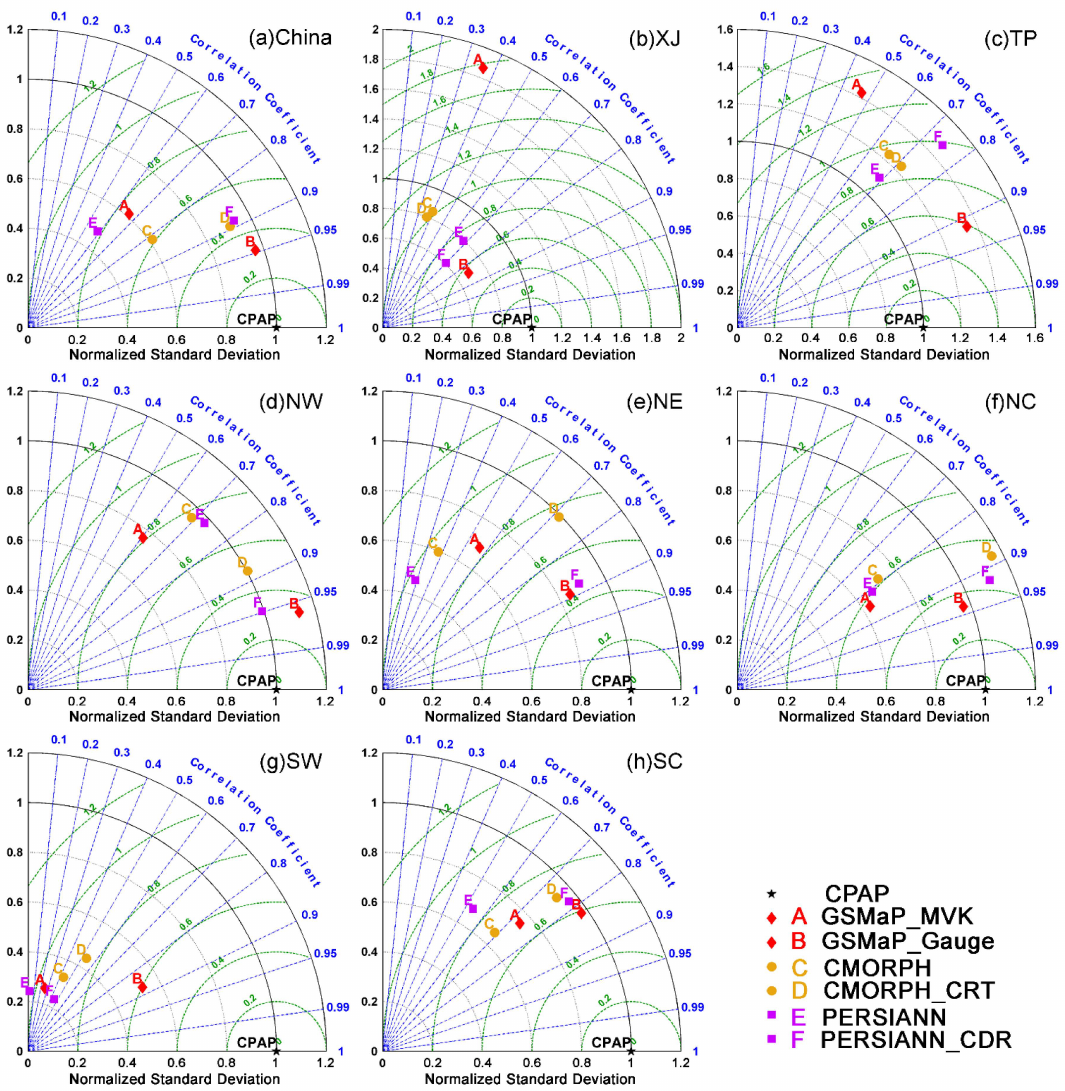
Figure 4. Taylor diagrams showing the correlation coefficients, the normalized standard deviation, and the RMSE of four year daily mean precipitation between six satellite-based precipitation products and the reference data over ( a ) mainland China and seven sub-regions: ( b ) XJ; ( c ) TP; ( d ) NW; ( e ) NE; ( f ) NC; ( g ) SW; and ( h ) SC. The radial coordinate is the magnitude of the standard deviation, which is normalized by the standard deviation from CPAP and denoted by black dotted lines. The concentric green semi-circles denote RMSE values. The angular coordinate shows the correlation coefficient (denoted by blue dotted lines). In these Taylor diagrams, the closer the points representing the satellite-based precipitation products are to the CPAP point (marked by the black pentagon), the better the product is with relatively high correlation, low standard deviation and RMSE values. The products from the same algorithm are marked by the same marker with same color and denoted by different characters with the same color. CPAP is marked by a black solid pentagon, while GSMaP_MVK and GSMaP_Gauge are marked by red diamonds and denoted by red A and B, respectively. CMORPH and CMORPH_CRT are marked by orange solid circles and denoted by orange C and D, respectively, whereas PERSIANN and PERSIANN_CDR are marked by purple squares and denoted by purple E and F,